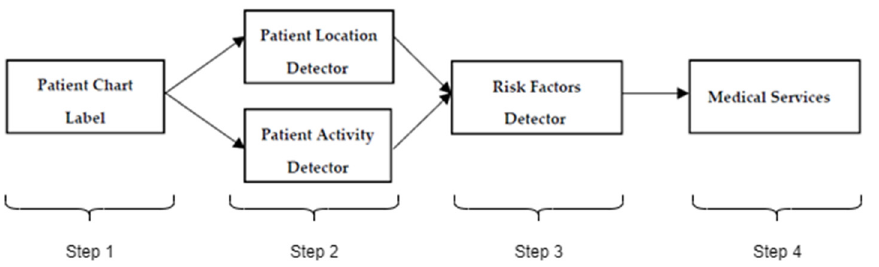
Figure 6. Reasoning process